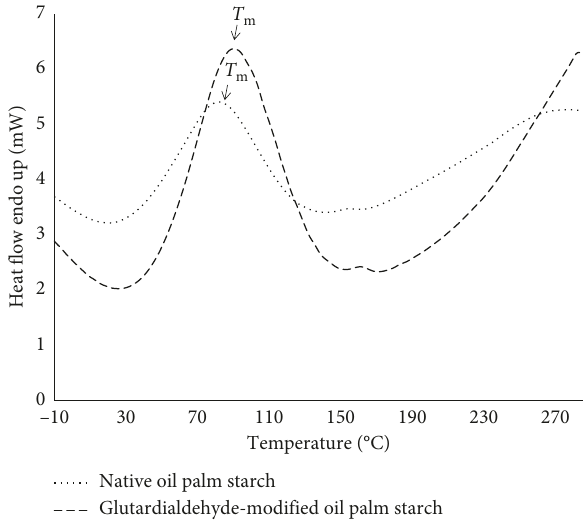
Figure 5: Differential scanning calorimetry curves of the OPS wood composite powder and OPSMG wood composite